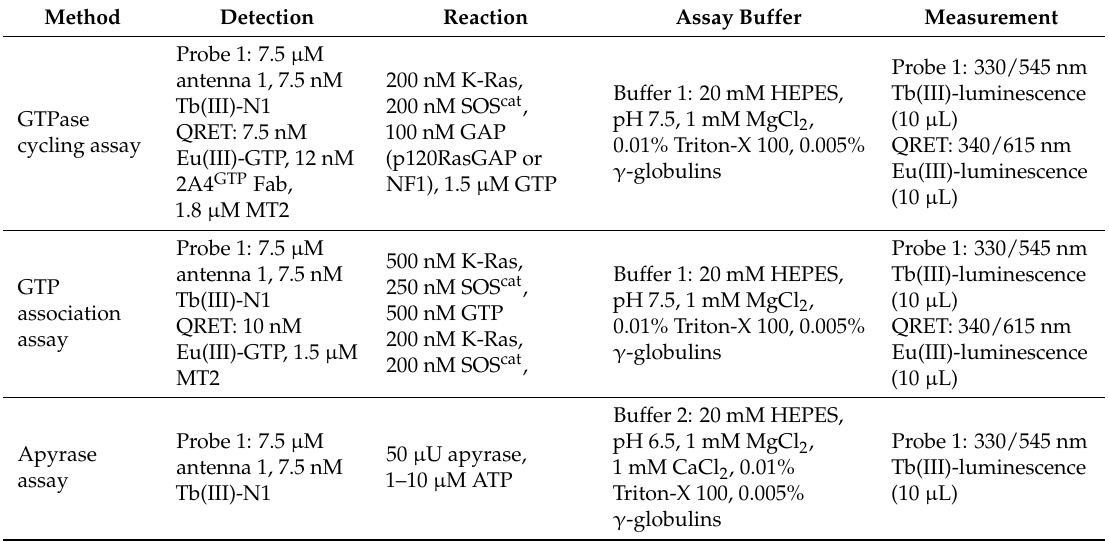
Table 1. Summarized K-Ras GTPase cycling and GTP association and apyrase ATPase assay